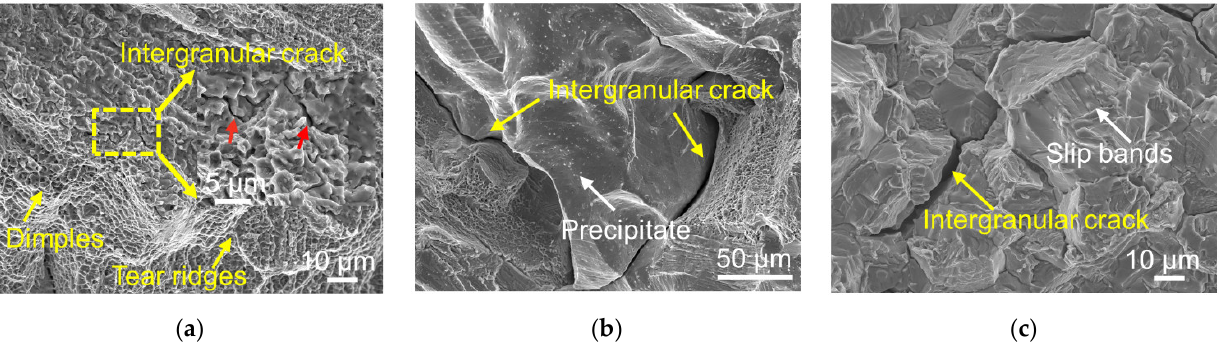
Figure 5. Fracture surfaces of post-creep samples tested at 650 °C/700 MPa: ( a ) DA, ( b ) HIP-DA, ( c ) Wrought .